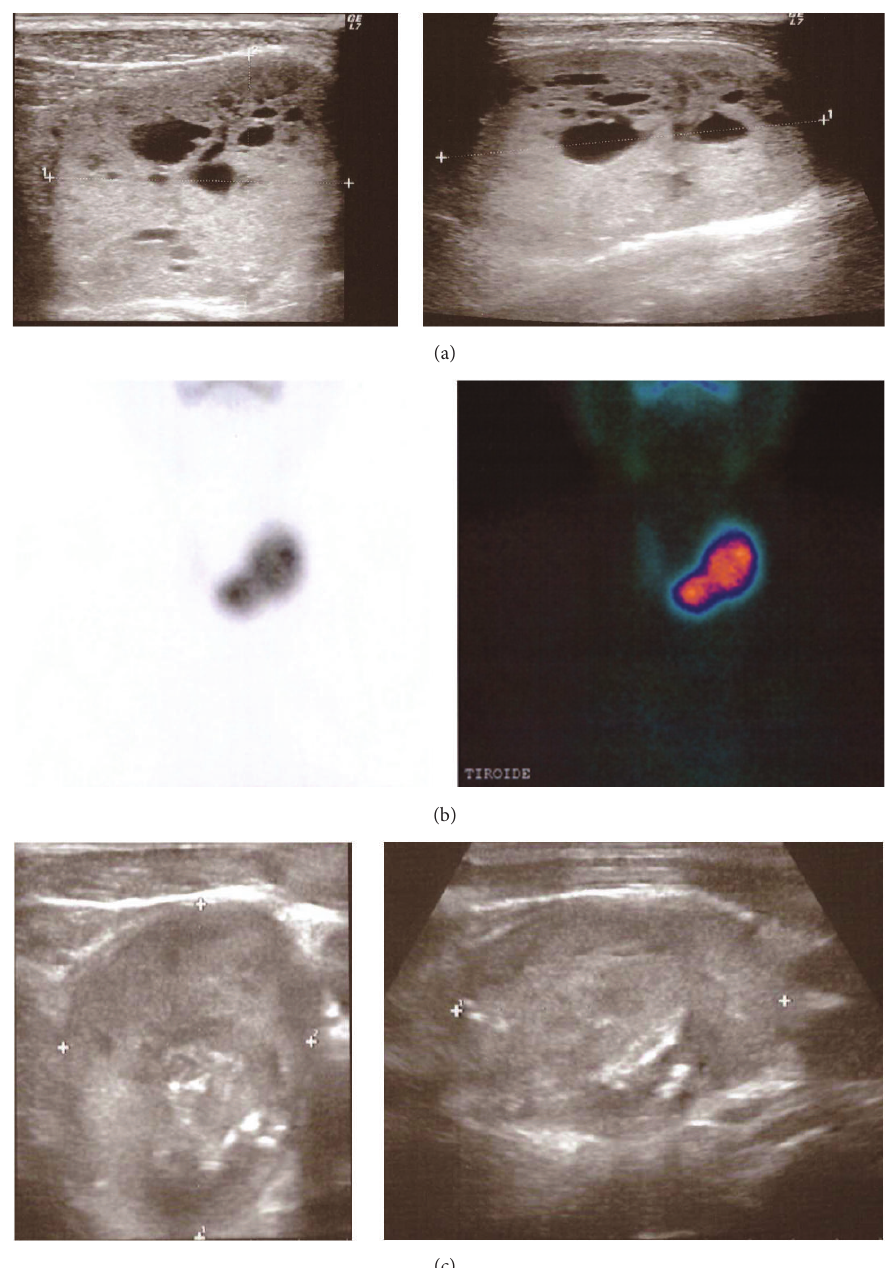
Figure 1: (a) Ultrasound of left lobe nodule at baseline; (b) thyroid scan (99mTc-pertechnetate); and (c) ultrasound of left lobe nodule after LAT + 131I